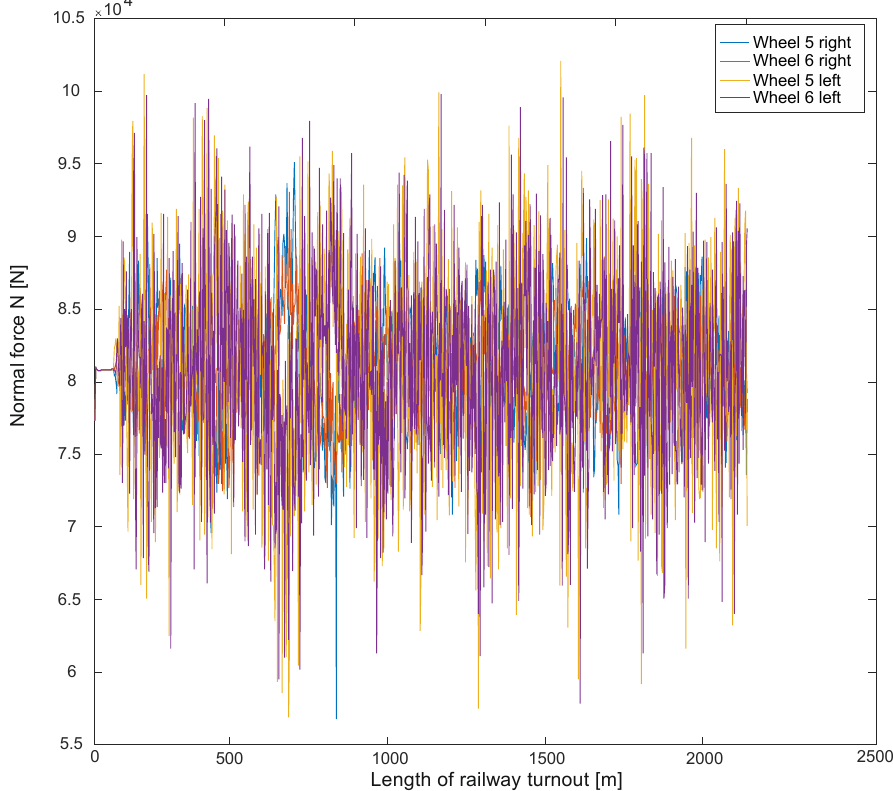
Figure 27. Normal force at 350 km/h on a straight track without a turnout.